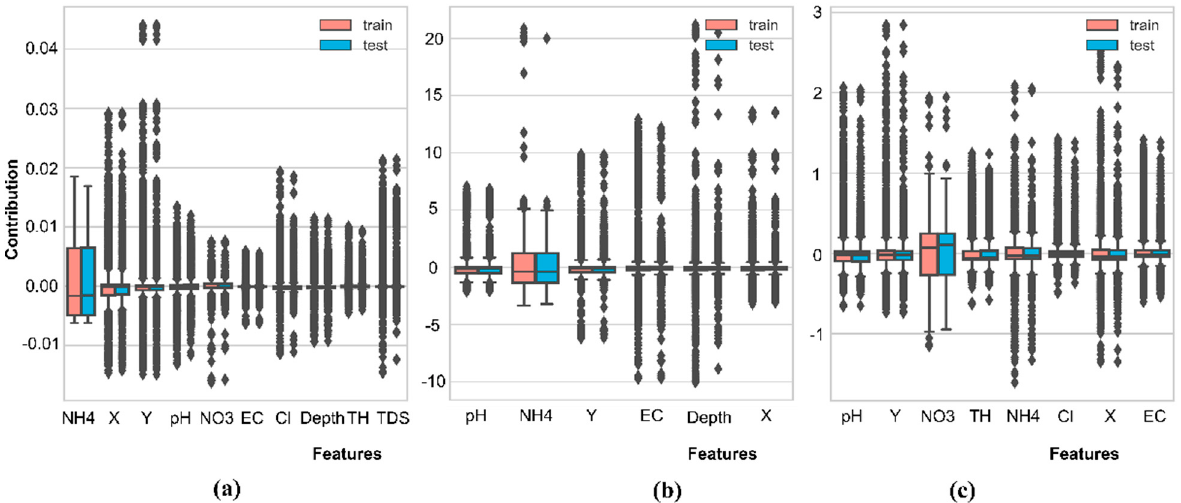
Figure 12. Distribution of local feature contributions for each predicted sample: ( a ) As model; ( b ) Fe model; ( c ) Mn model. Table 7. Global feature contributions in each model.